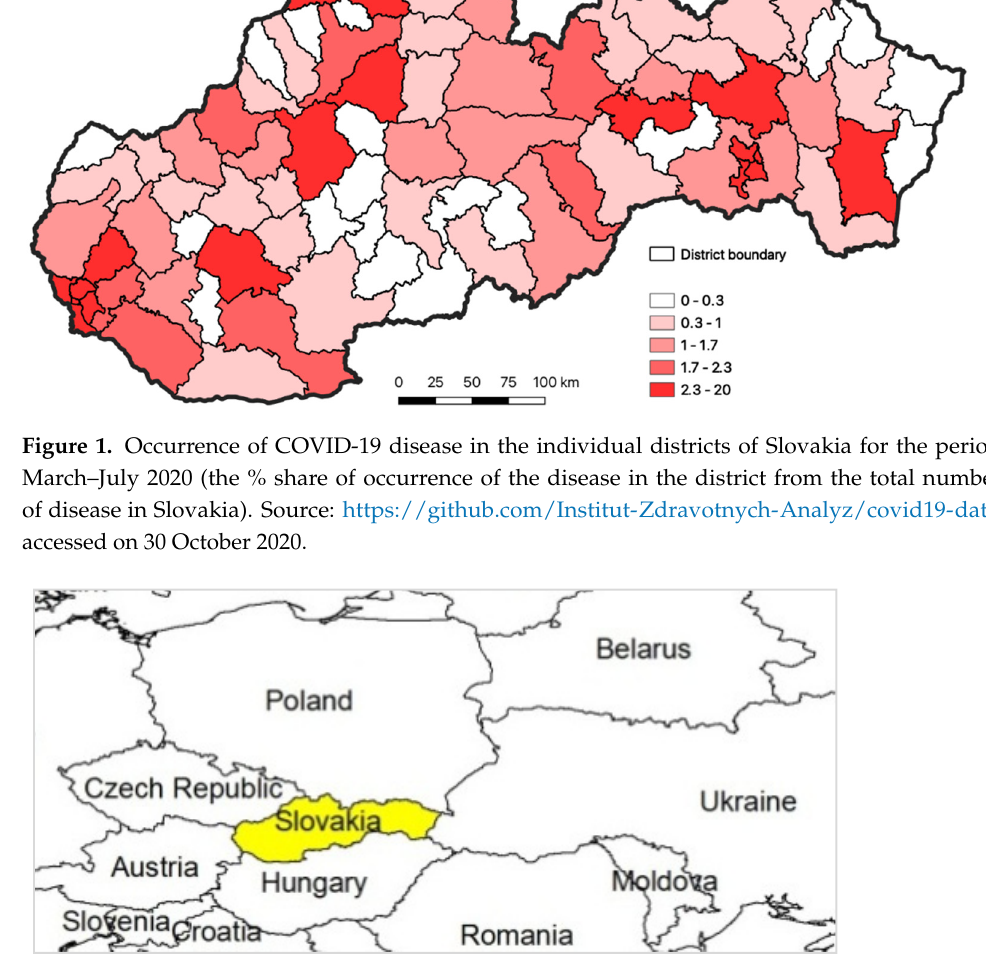
Figure 2. Location of Slovakia.